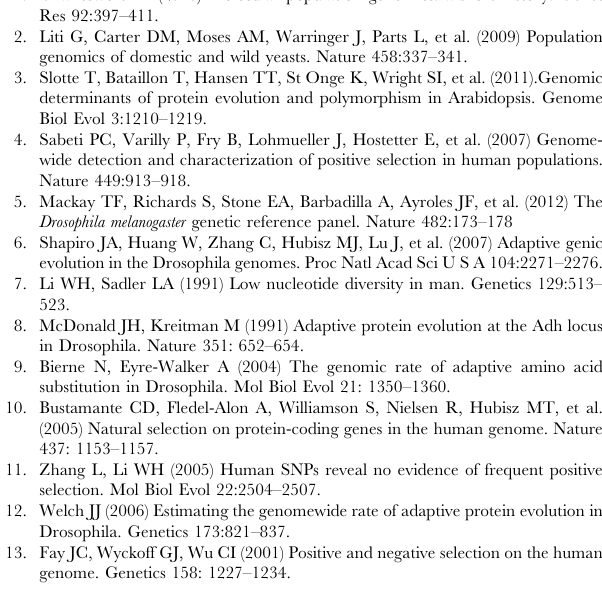
Figure S2 Mitochondrial DNA ( cox1 ) trees for the five species analysed in this study. Sample labels: see Table S1. Reference sequences (blue) were taken from Genbank. S2a: turtle; S2b: hare;